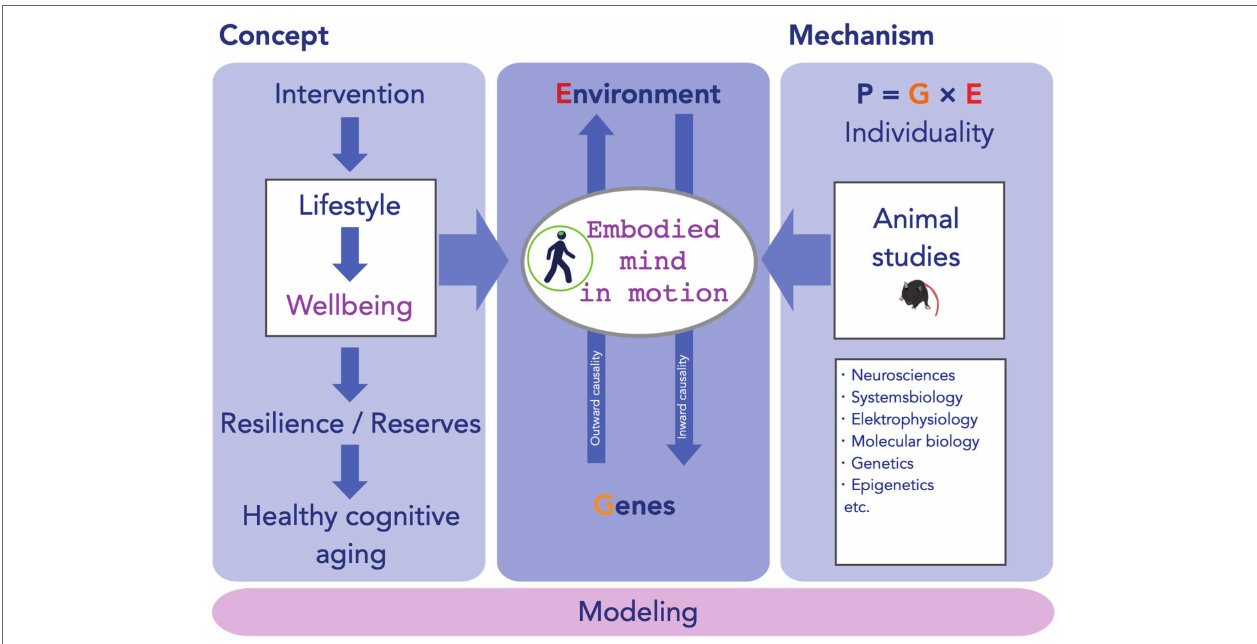
FIGURE 1 | Embodied prevention. The concept underlying lifestyle interventions for healthy cognitive aging is based on the assumption that a lifestyle-changing intervention results in an increase in resilience in old age and a preservation of reserves. The emphasis here lies in the fact that in order to be sustainable, lifestyle must also have motivating effects on wellbeing now. The embodied mind lies at the center of this context, because body and mind cannot be thought separately in this context. Behavior in the environment and the underlying genetic predispositions and causes are linked in a bi-directionality chain or network of causalities, intersecting in the embodied mind in motion. Animal studies and other types of reductionist research can aid understanding this core concept and unraveling mechanisms underlying the equilibria of wellbeing, the embodiment in motion itself, and the interindividual variation of this effect, by building upon the fundamental principle that any phenotype and its variation draws from an interaction of genetic and non-genetic causes. Here the non-shared factor of the environmental effect, which includes individual behavior and actions is of particular interest. Future models of lifestyle based embodied prevention need to include all three